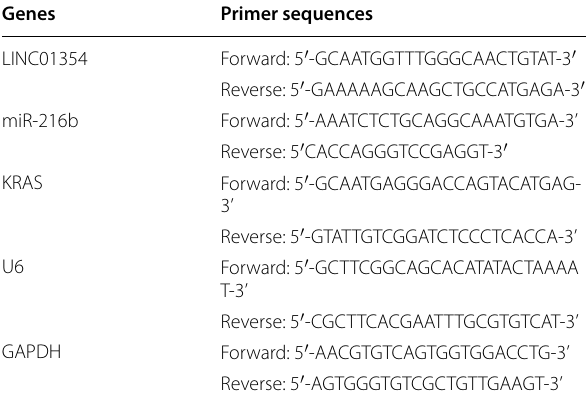
Table 1 Primer sequences for genes used in